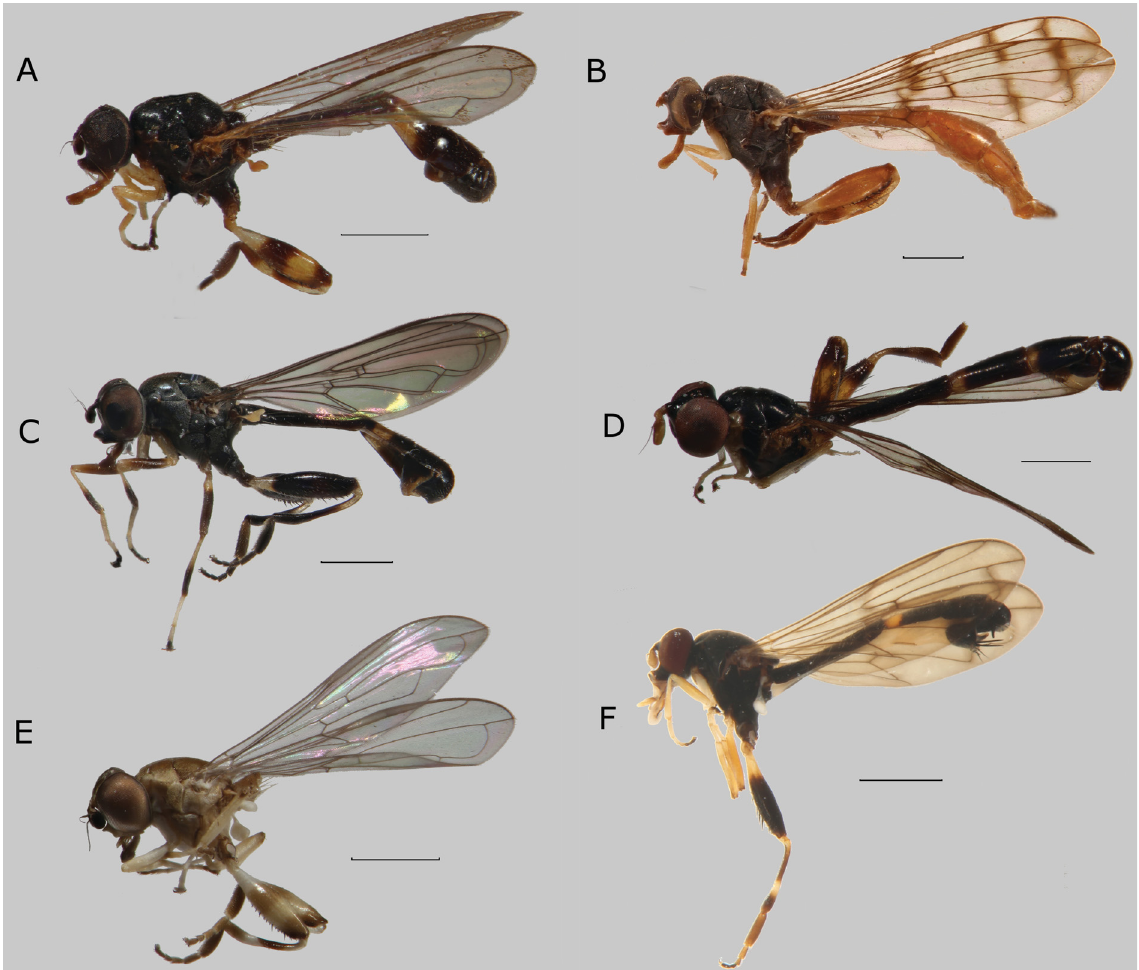
Fig. 63. Habitu s, lateral view. A . Sphegina (Asiosphegina) minuta Hippa, van Steenis & Mutin, 2015, paratype, ♂ , Myanmar. B . S. (A.) miri fi ca Hippa, van Steenis & Mutin, 2015, ♀ , Myanmar. C . S. (A.) nigerrima Shiraki, 1930, ♂ , Taiwan. D . S. (A.) nigrotarsata sp. nov., paratype, ♂ , Vietnam. E . S. ( A.) nubicola sp. nov., holotype, ♂ , Thailand. F . S. ( A.) ornata sp. nov., holotype, ♂ , China. Scale bars = 1.0